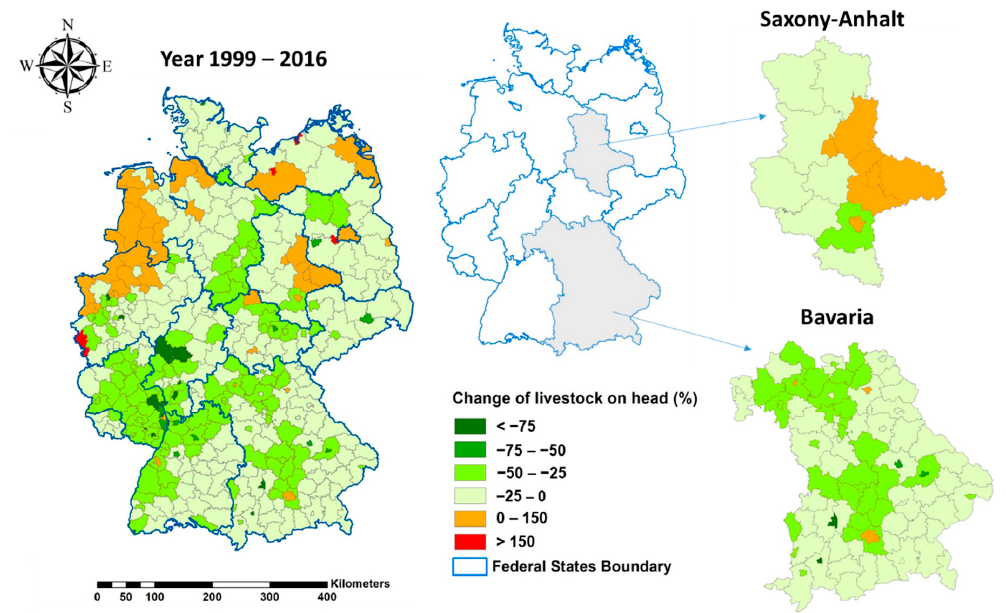
Figure 6. Germany county-level livestock unit on hand change.